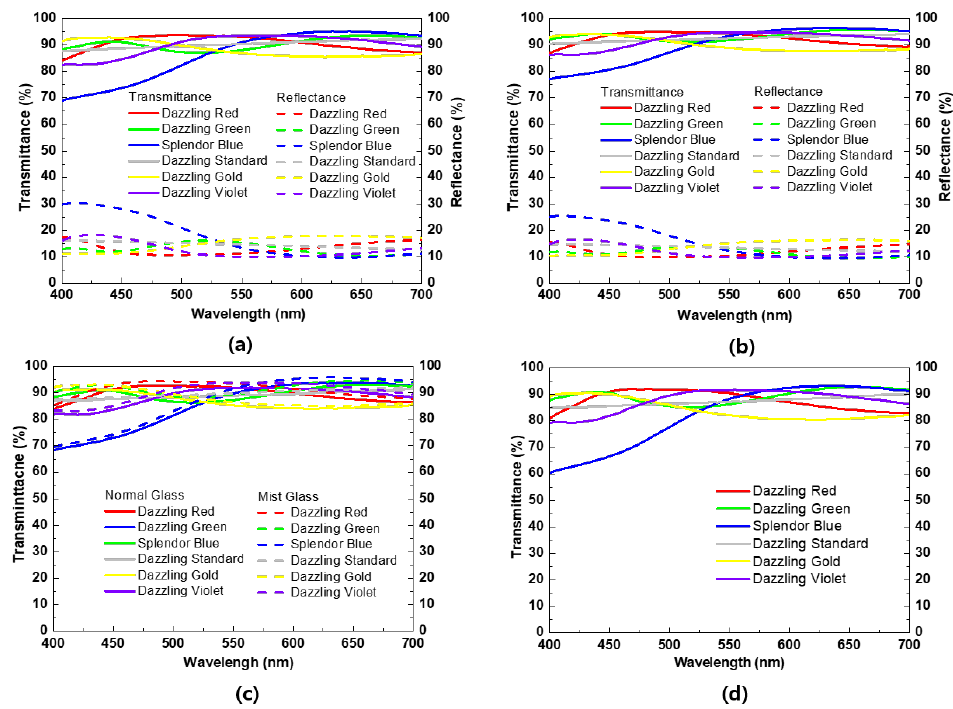
Figure 4. Transmittance and reflectance spectra of color glass spin coated at ( a ) 1500 rpm, and ( b ) 3000 rpm. Transmittance spectra of pearlescent pigments on normal and mist glass at spin-coating speed of ( c ) 1500 rpm and ( d ) 1000 rpm on 3 × 8 cm 2 solar cell.